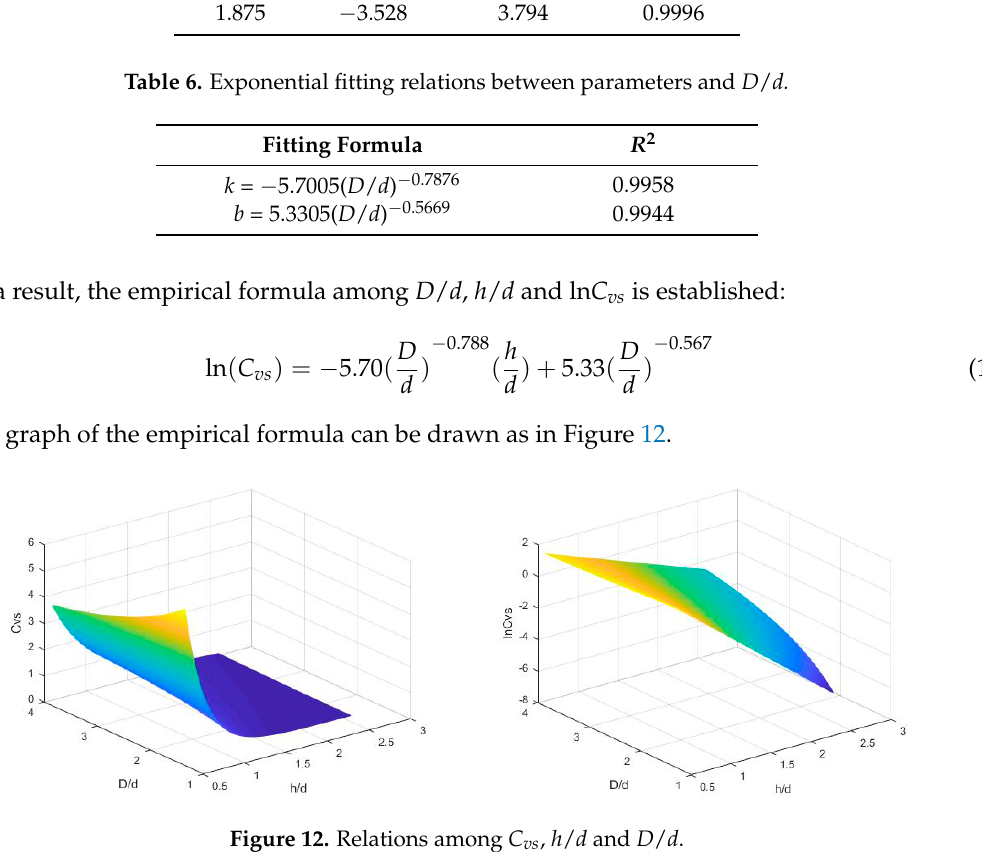
Table 5. Linear fitting parameters of ln( C vs )~ h / d .